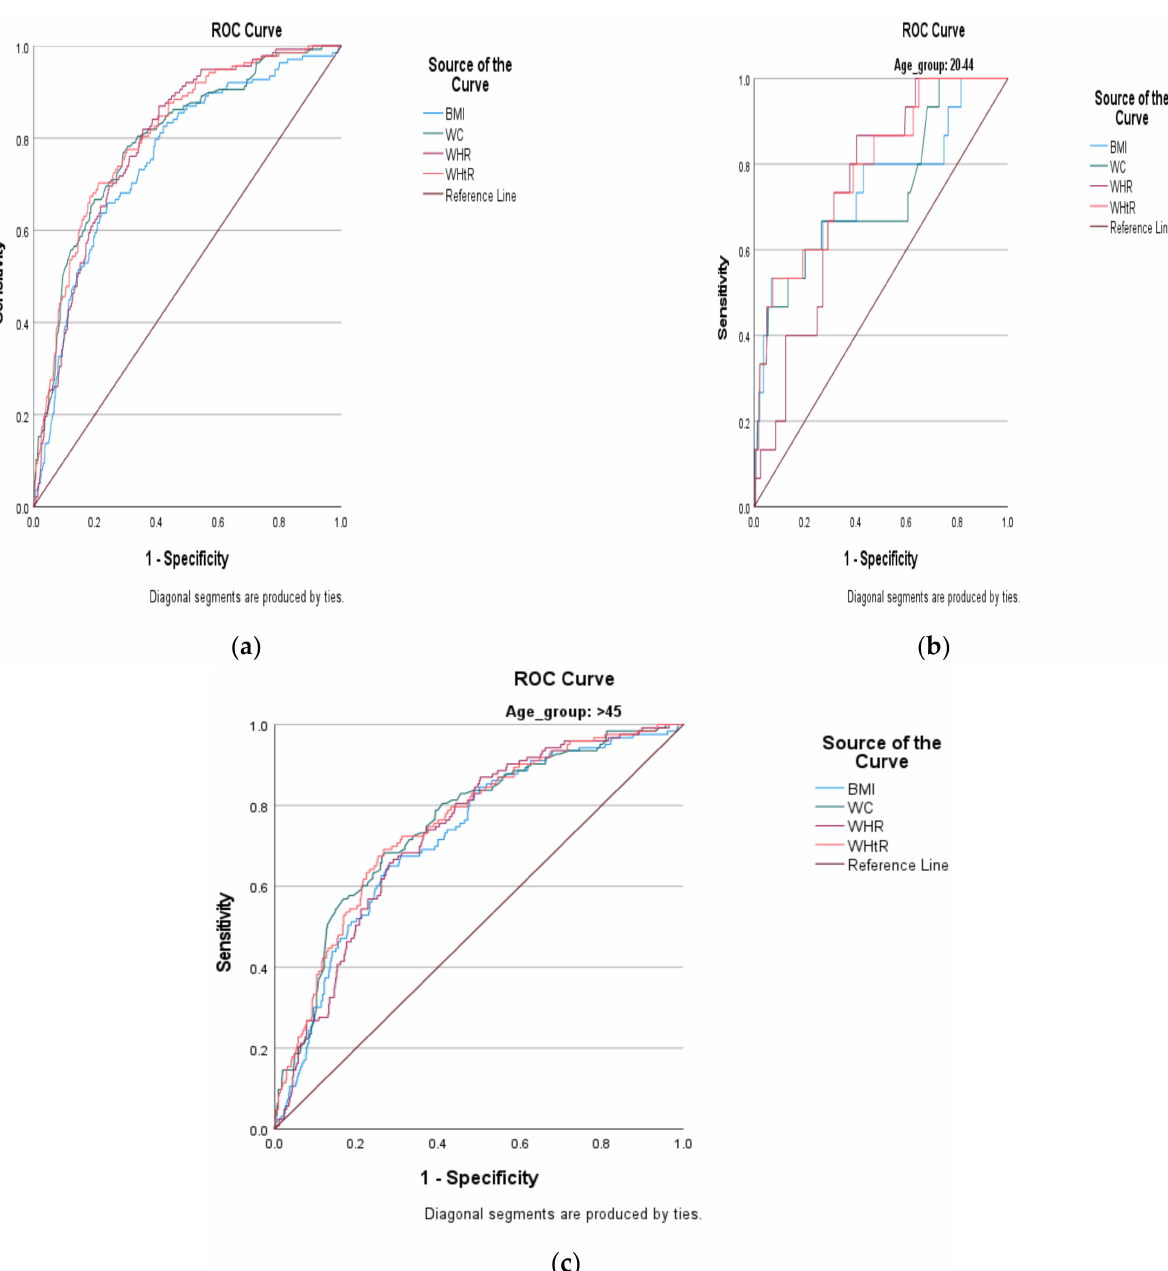
Figure 2. ( a ) ROC curves and optimal cut-off values for anthropometric indices in the prediction of diabetes mellitus in South African males aged 20 years and older. ( b ) ROC curves and optimal cut-off values for anthropometric indices in the prediction of diabetes mellitus in South African males who are 20–44 years old. ( c ) ROC curves and optimal cut-off values for anthropometric indices in the prediction of diabetes mellitus in South African males who are >45 years